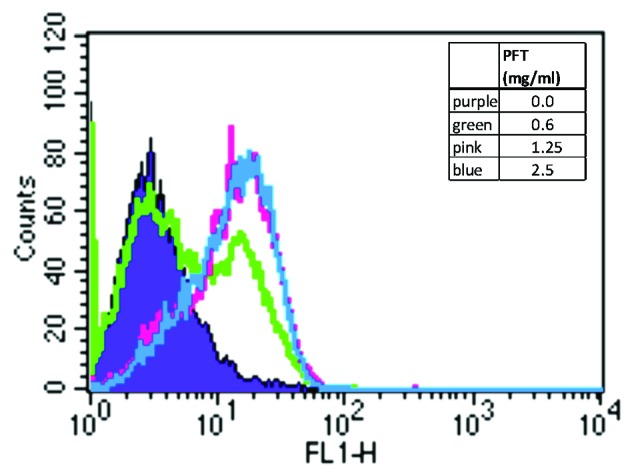
PFT induces apoptosis through activation of caspase 3. The activation of caspase 3 was determined in cancer cells post-culture with PFT at different concentrations (0, 0.6, 1.25 and 2.5 mg/ml). The lines represent cancer cells in the absence of PFT (control, purple) and cancer cells treated with PFT at concentration of 0.6 mg/ml (green), 1.25 mg/ml (pink), or 2.5 mg/ml (blue). The activation of caspase 3 in cells was detected using carboxyfluorescein-labeled cell permeable peptide substrate and was analyzed using flow cytometry.